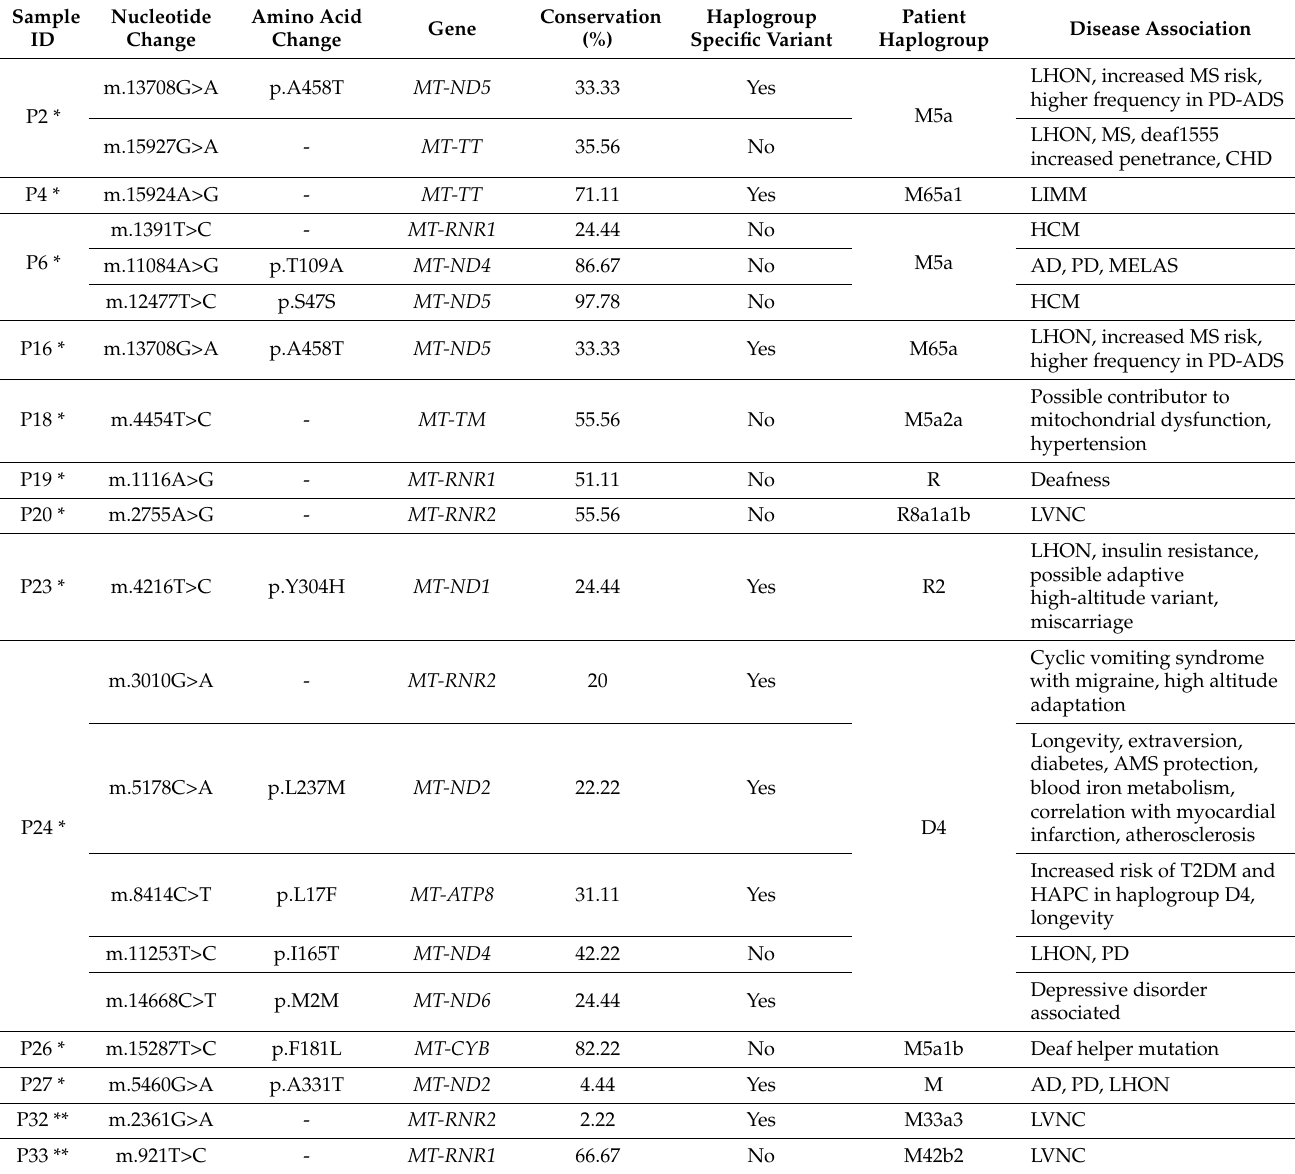
Table 3. List of other disease-associated mtDNA variants identified in the patients harbouring primary LHON variants. Sample